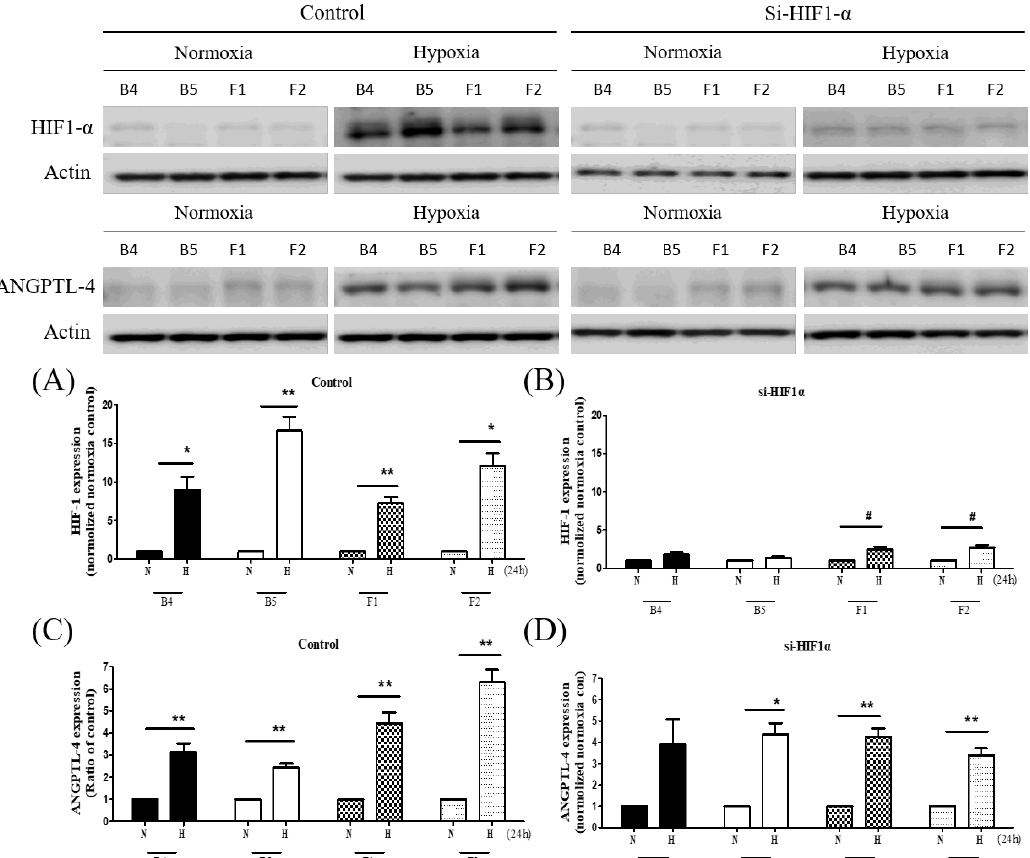
Figure 6. ANGPTL4 expression in di ff erent cybrids under hypoxia-ischemia and the relationship with HIF-1 α . Comparison of the knockdown e ff ect of HIF-1 α siRNA on expressions of HIF-1 α and ANGPTL4 in cybrid cells harboring stroke-susceptible haplogroup F and resistant haplogroup B. Baseline expression of HIF-1 α ( A ) and ANGPTL4 ( C ) and e ff ects of HIF-1 α siRNA on expressions of HIF-1 α ( B ) and ANGPTL4 ( D ) before and after hypoxia-ischemia, as assessed by Western blot analysis. Actin was used as a loading control. Data represent the mean ± SD of at least three independent experiments (* p < 0.05; # p < 0.005). N was used to represent normoxic and H to represent the hypoxic